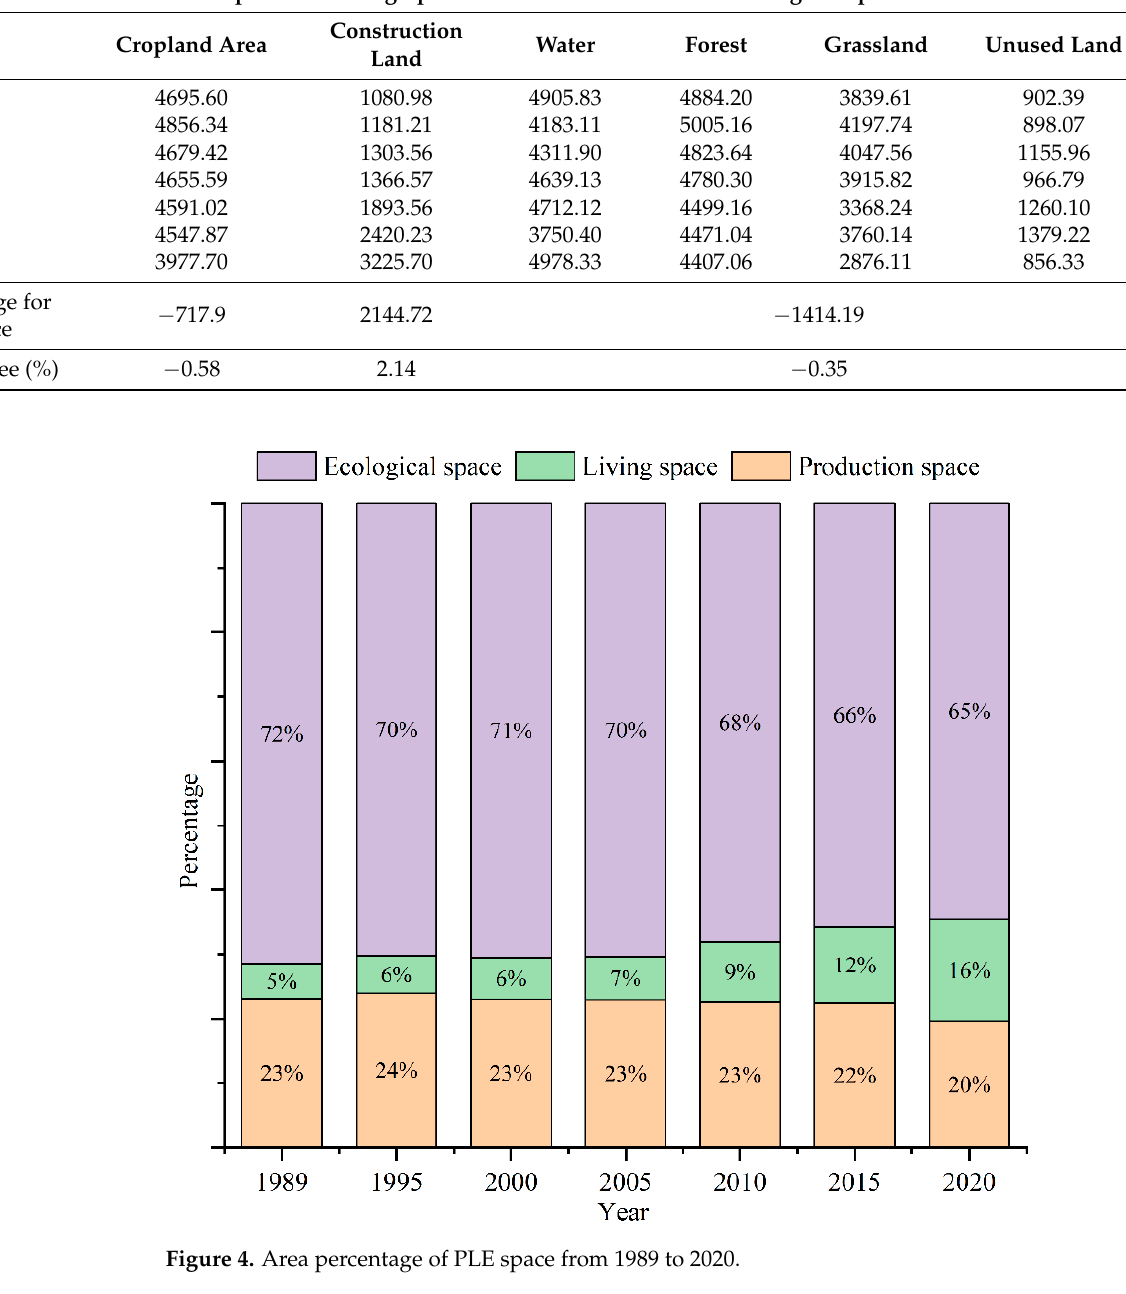
Figure 5. Spatial classification map of PLE space in the PYL area from 1989 to 2020.